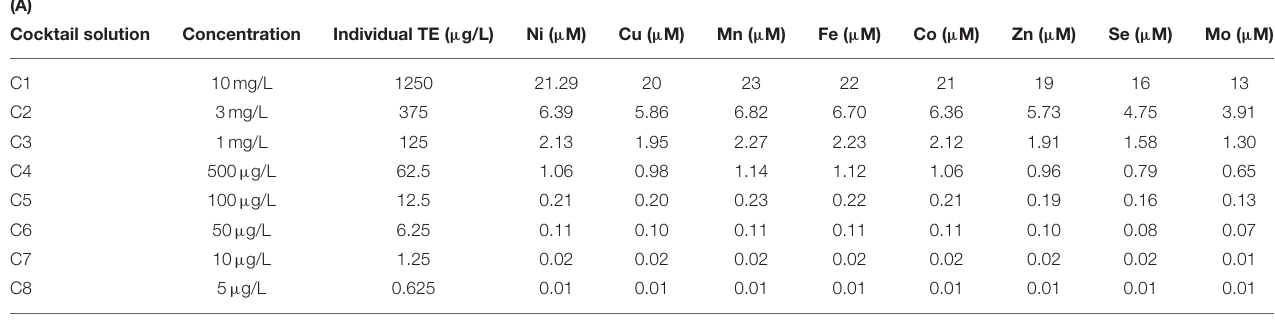
TABLE 3 | Effect of TE concentrations on the net SBP of FW-A: (A) First set of experiment; and (B) Second set of experiment.